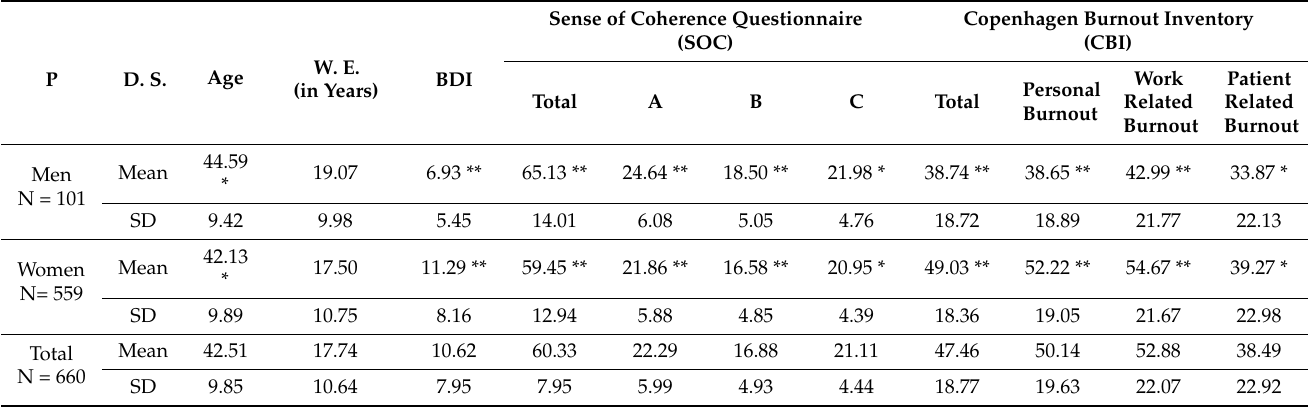
Table 2. Correlations among age, work experience (in years), CBI, SOC, and BDI.